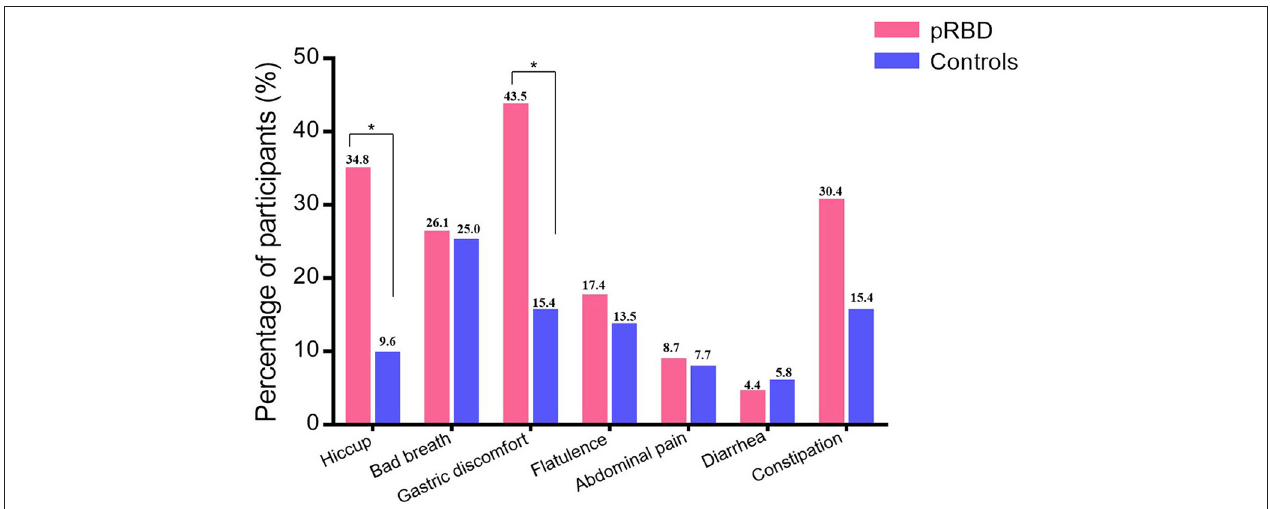
FIGURE 2 | The subjective gastrointestinal function in healthy controls and participants with probable REM behavior disorder (pRBD). The prevalence of hiccup and postprandial gastric discomfort were higher in participants of pRBD than healthy controls (34.8 vs. 9.6%, p = 0.017; 43.5 vs. 15.4%, p = 0.017). The prevalence of bad breath ( p = 0.61), flatulence ( p = 0.73), diarrhea ( p = 1.0), abdominal pain ( p = 1.0), and constipation ( p = 0.2) were similar between two groups. * P < 0.05.